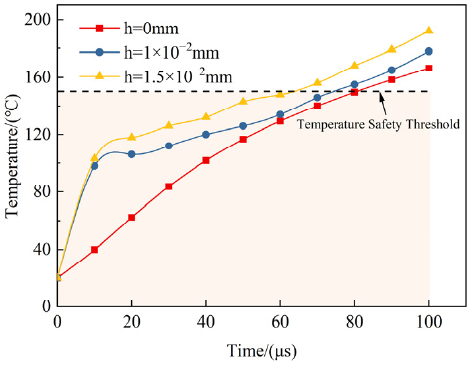
Figure 5. Temperature distribution of water film working conditions at different heights.